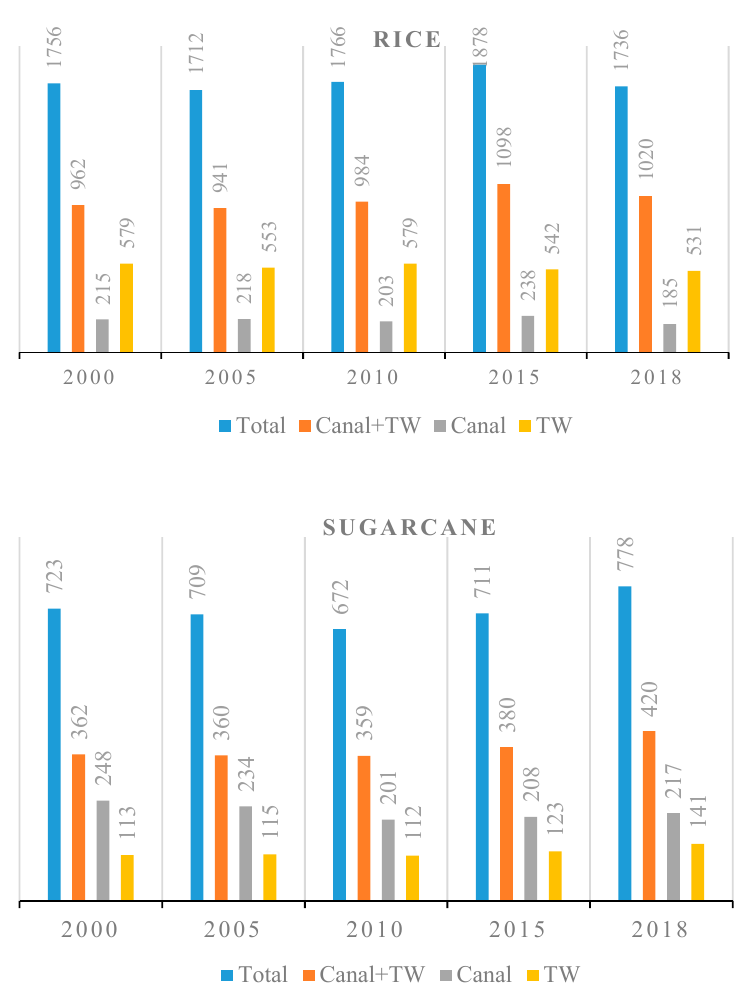
Figure 7. Area of three major crops irrigated (‘000 ′ ha) by different modes of irrigation in Punjab (TW = Tubewell) (Source: Punjab Irrigation Department).